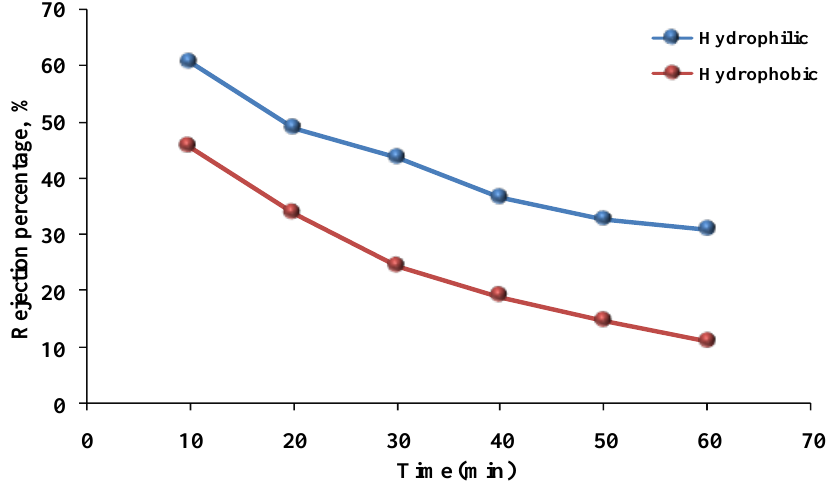
Figure 11. Phenol solution’s rejection percentage versus time for hydrophilic and hydrophobic membranes (pressure = 1 bar, temperature = 30 °C, phenol concentration = 50 mg/L).